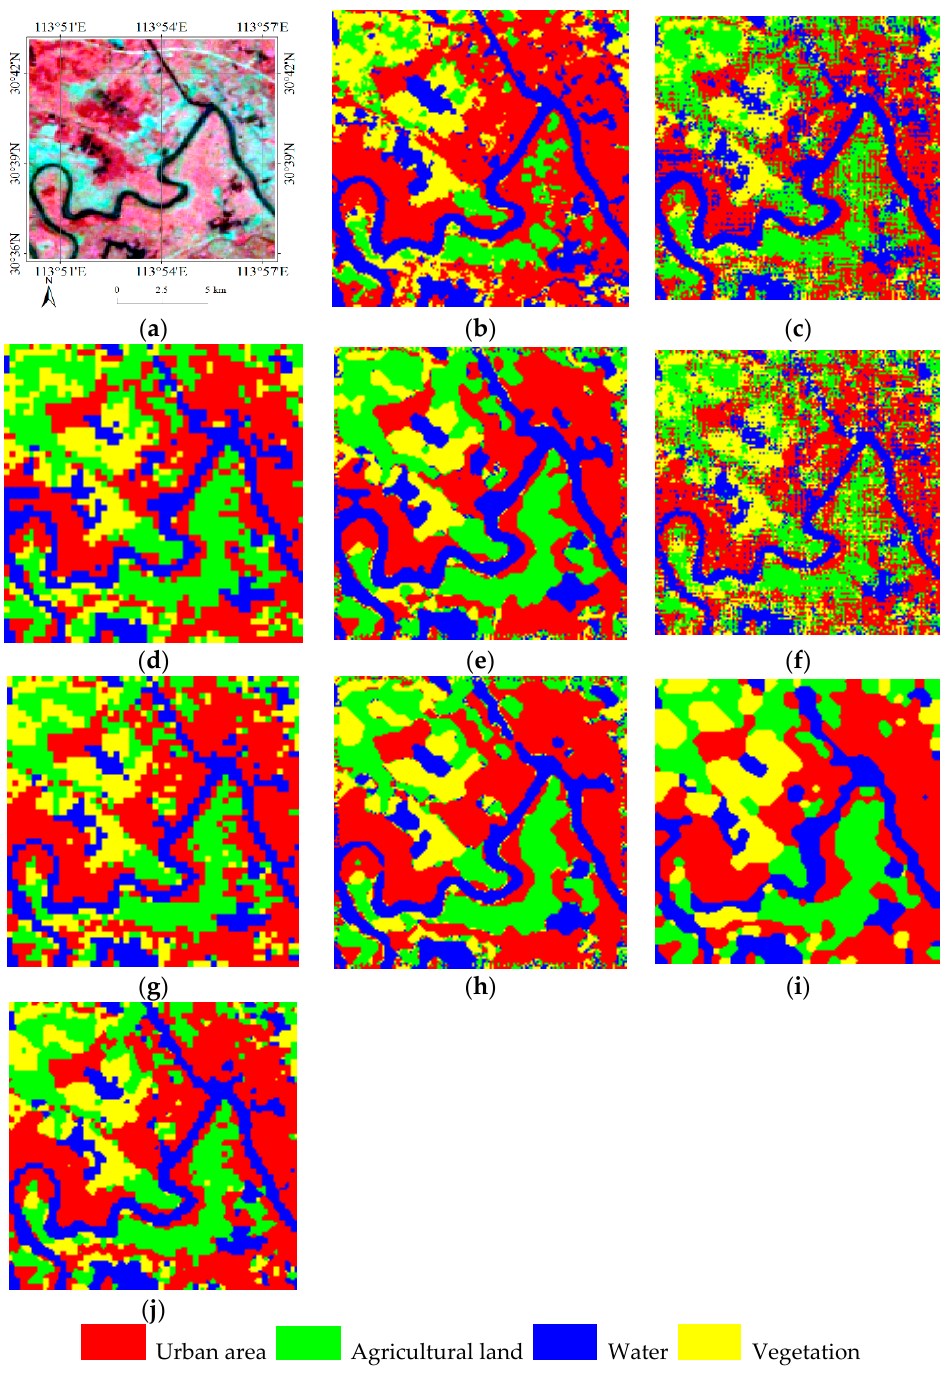
Figure 3. Sub-pixel mapping results for the synthetic dataset (HJ-1A): ( a ) original high-resolution remotely sensed imagery; ( b ) reference classification map obtained by SVM classifier; ( c ) sub-pixel mapping result obtained using FCLS+AM, ( d ) FCLS+HC, ( e ) FCLS+HNN, ( f ) SUnSAL-TV+AM, ( g ) SUnSAL-TV+HC, ( h ) SUnSAL-TV+HNN, ( i ) MRF, ( j ) JSSM.